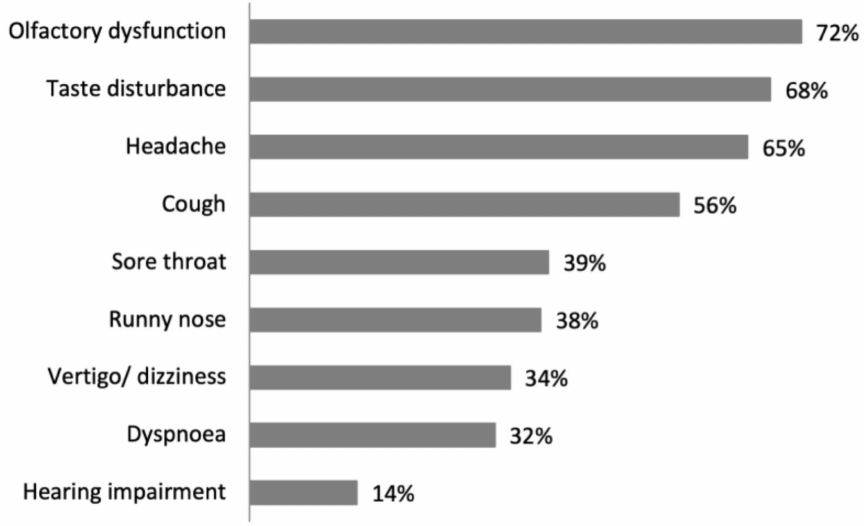
Figure 2. Distribution of the frequency of reported ENT symptoms.